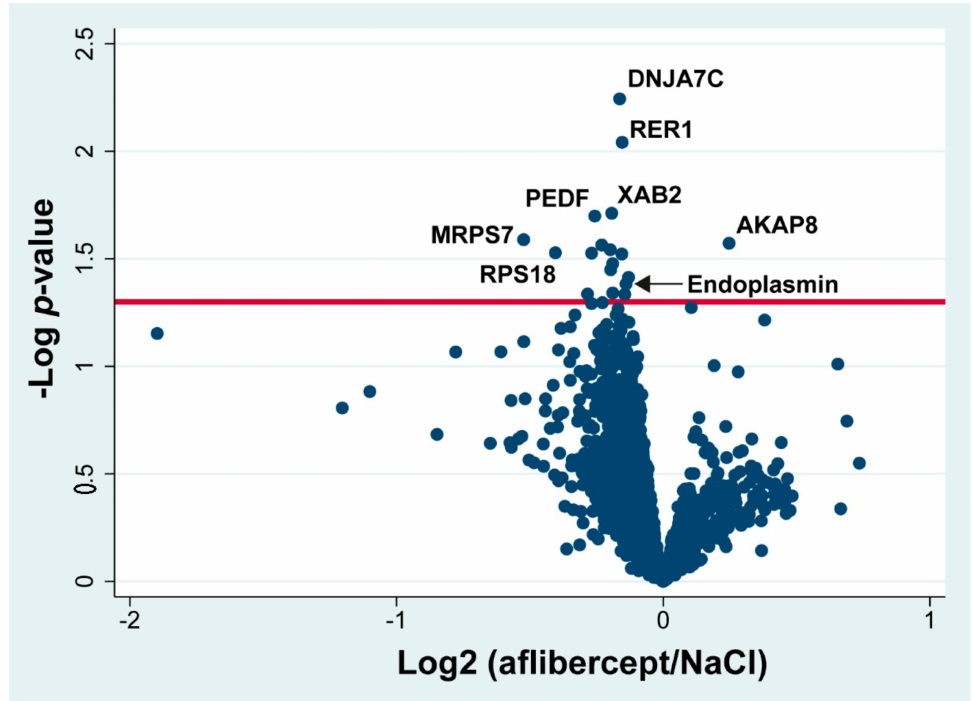
Figure 4. Volcano plot. Log 2 of the ratio aflibercept/NaCl is plotted on the x-axis. On the y-axis, − log p -value refers to the logarithmized p -value from the t -test used to test if a protein was significantly changed. Statistically significantly changed proteins are located above the horizontal line, which denotes a significance level of 0.05. Components of aflibercept are not included in the volcano plot. PEDF: pigment epithelium-derived factor. DNAJ7C: DnaJ homolog subfamily C member 7. AKAP8: A-kinase anchor protein 8. XAB2: Pre-mRNA-splicing factor SYF1. MRPS7: 28S ribosomal protein S7, mitochondrial. RPS18: 40S ribosomal protein S18. RER1: Protein